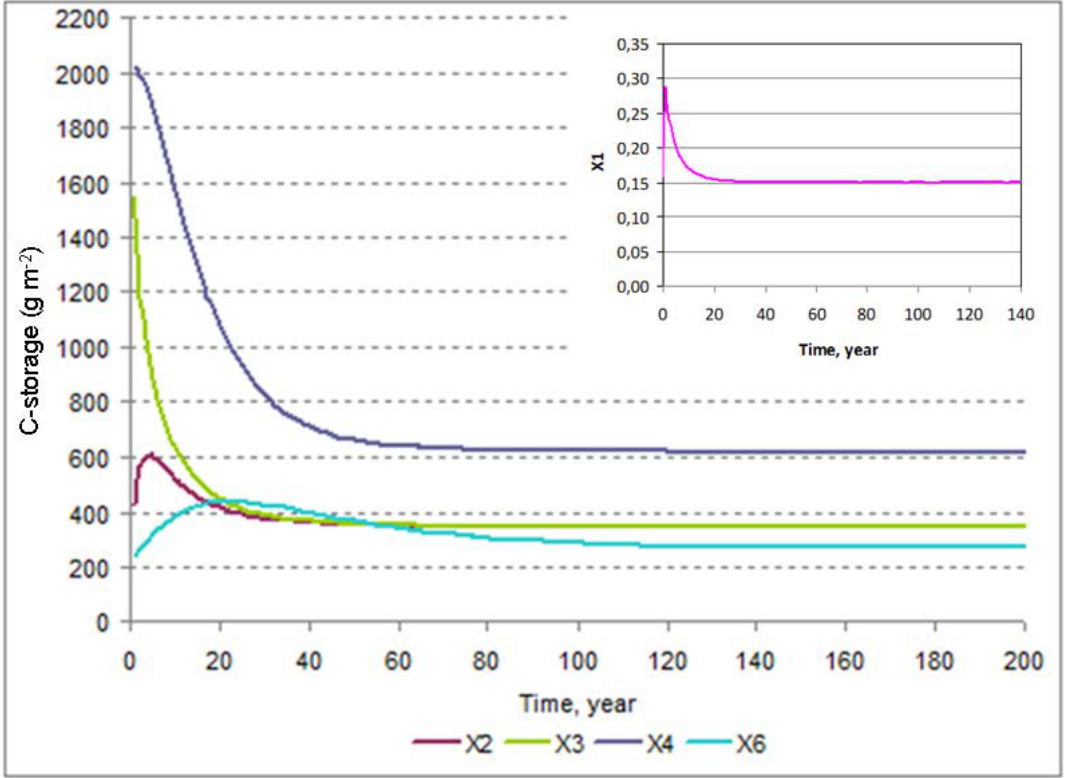
Figure 3. Time-course of X 1– X 4 and X 6 compartment storage values in PSS bog.